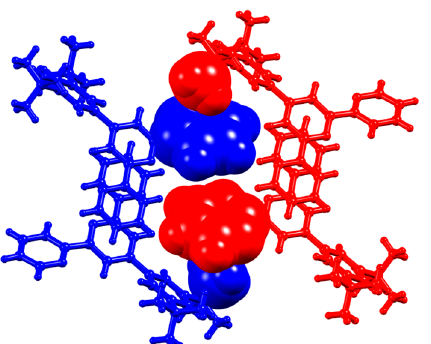
Figure 13. Adjacent centrosymmetric dimers { 6 · EtOH} 2 colored blue and red (EtOH molecules omitted for clarity) associate through CH tert -butyl . . . centroid pyridine contacts; methyl groups (of the tert -butyl) and pyridine rings are shown in space-filling representation. The central red and blue pyridine rings are not π -stacked.